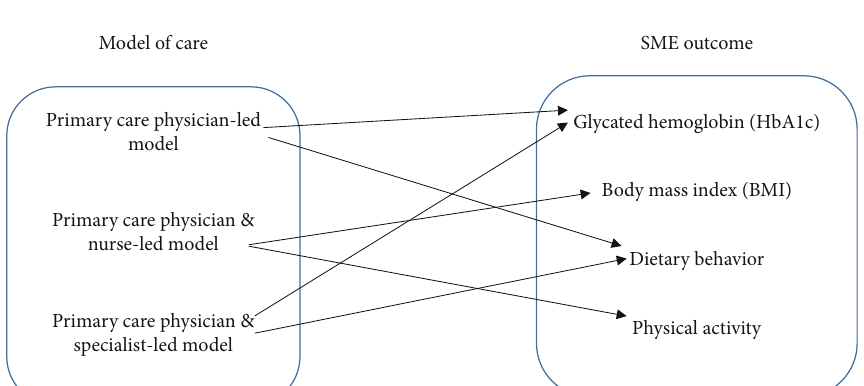
Figure 3: Models of diabetes care.